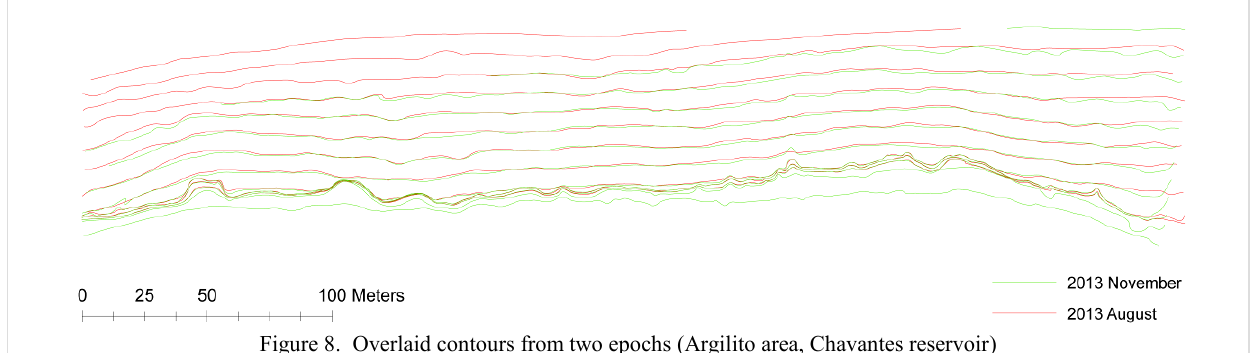
Figure 8. Overlaid contours from two epochs (Argilito area, Chavantes